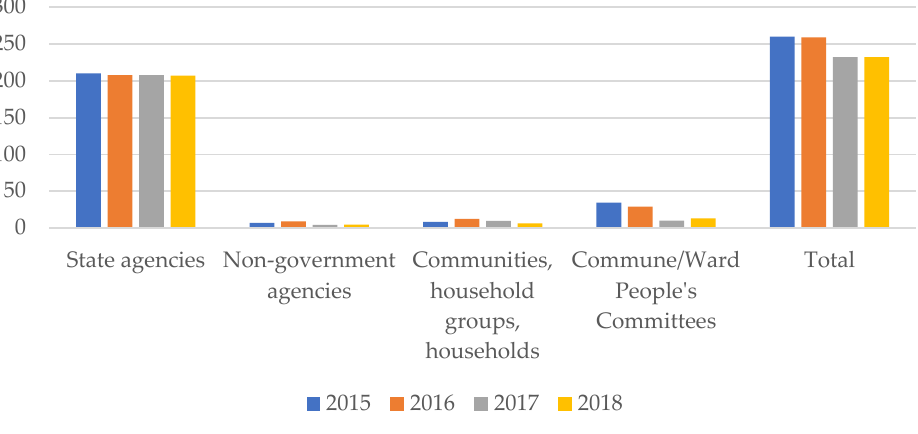
Figure 7. Forest area by forest owner receiving PFES ( × 1000 ha). Sources: [62–65]. Table 7. Payment rates for river basins in Dak Lak province (VND × 1000/ha/year).